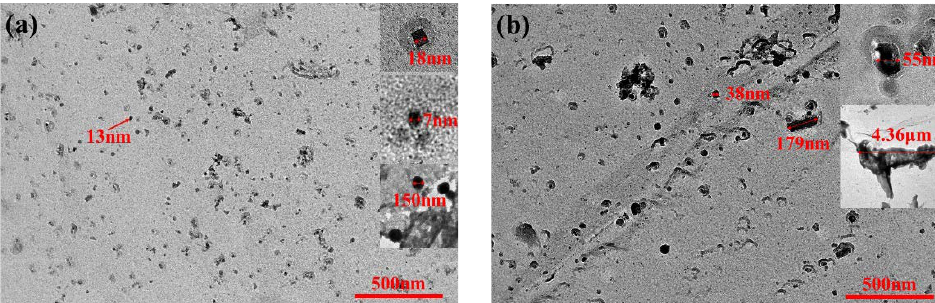
Figure 6. Morphology and distribution of precipitates with different C content. ( a ) ELC; ( b ) LC.